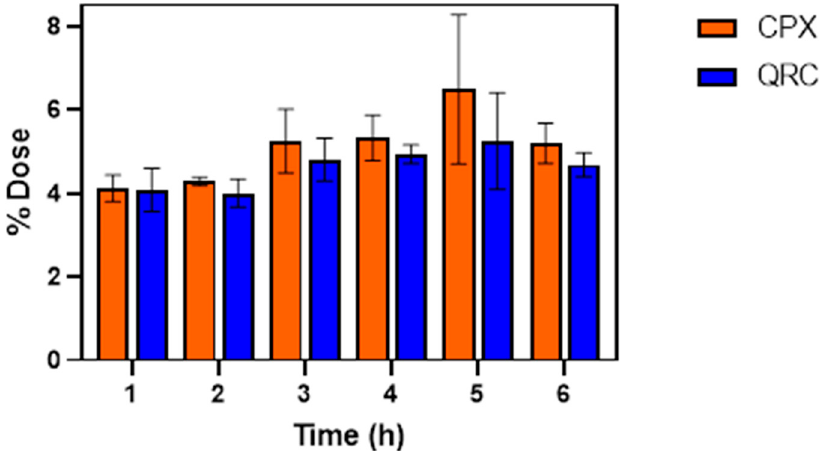
Figure 10. Percentage of CPX (orange) and QRC (blue) doses recovered into the porcine membrane at different time points (hours); means ± SE ( n = 3). Significant differences between CPX and QRC groups ( p < 0.05).